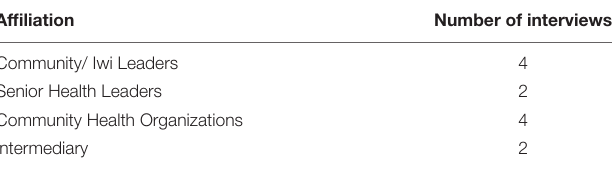
TABLE 1 | Interviewee